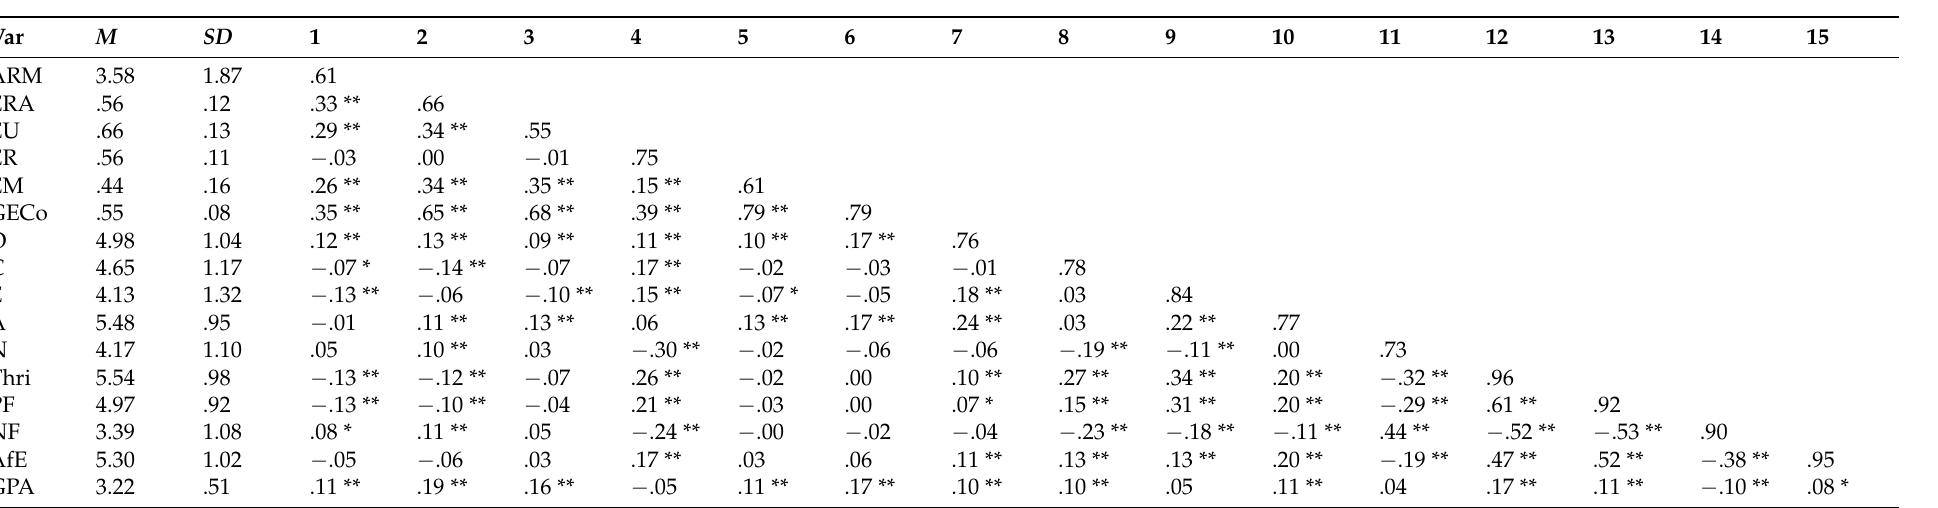
Table 2. Means, standard deviations, and correlations ( N =